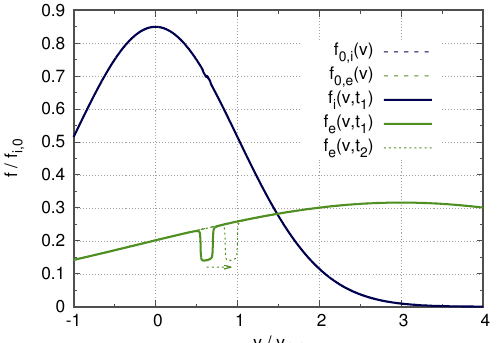
Figure 12. Velocity distribution of ions and electrons in a two-species plasma with a mean velocity drift. The equilibrium distributions are noted f 0, i and f 0, e . The ion/electron mass ratio is reduced to 10 for the sake of readability of the figure. An electron hole is drawn schematically at some arbitrary time t = t 1 , and the mechanism of its growth from t = t 1 to a later time t 2 is explained in the text as the result of a drag force due to the scattering of ions by the electron hole.